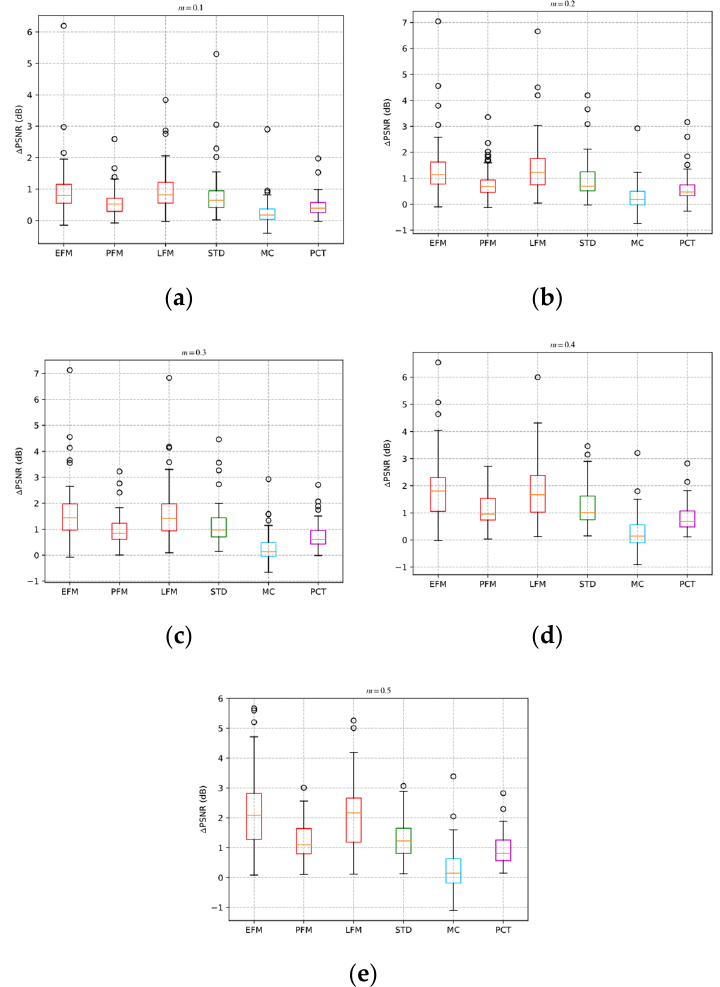
Figure 16. PSNR gains of different ABCS schemes for different sampling rates: ( a ) m = 0.1; ( b ) m = 0.2; ( c ) m = 0.3; ( d ) m = 0.4; ( e ) m = 0.5.